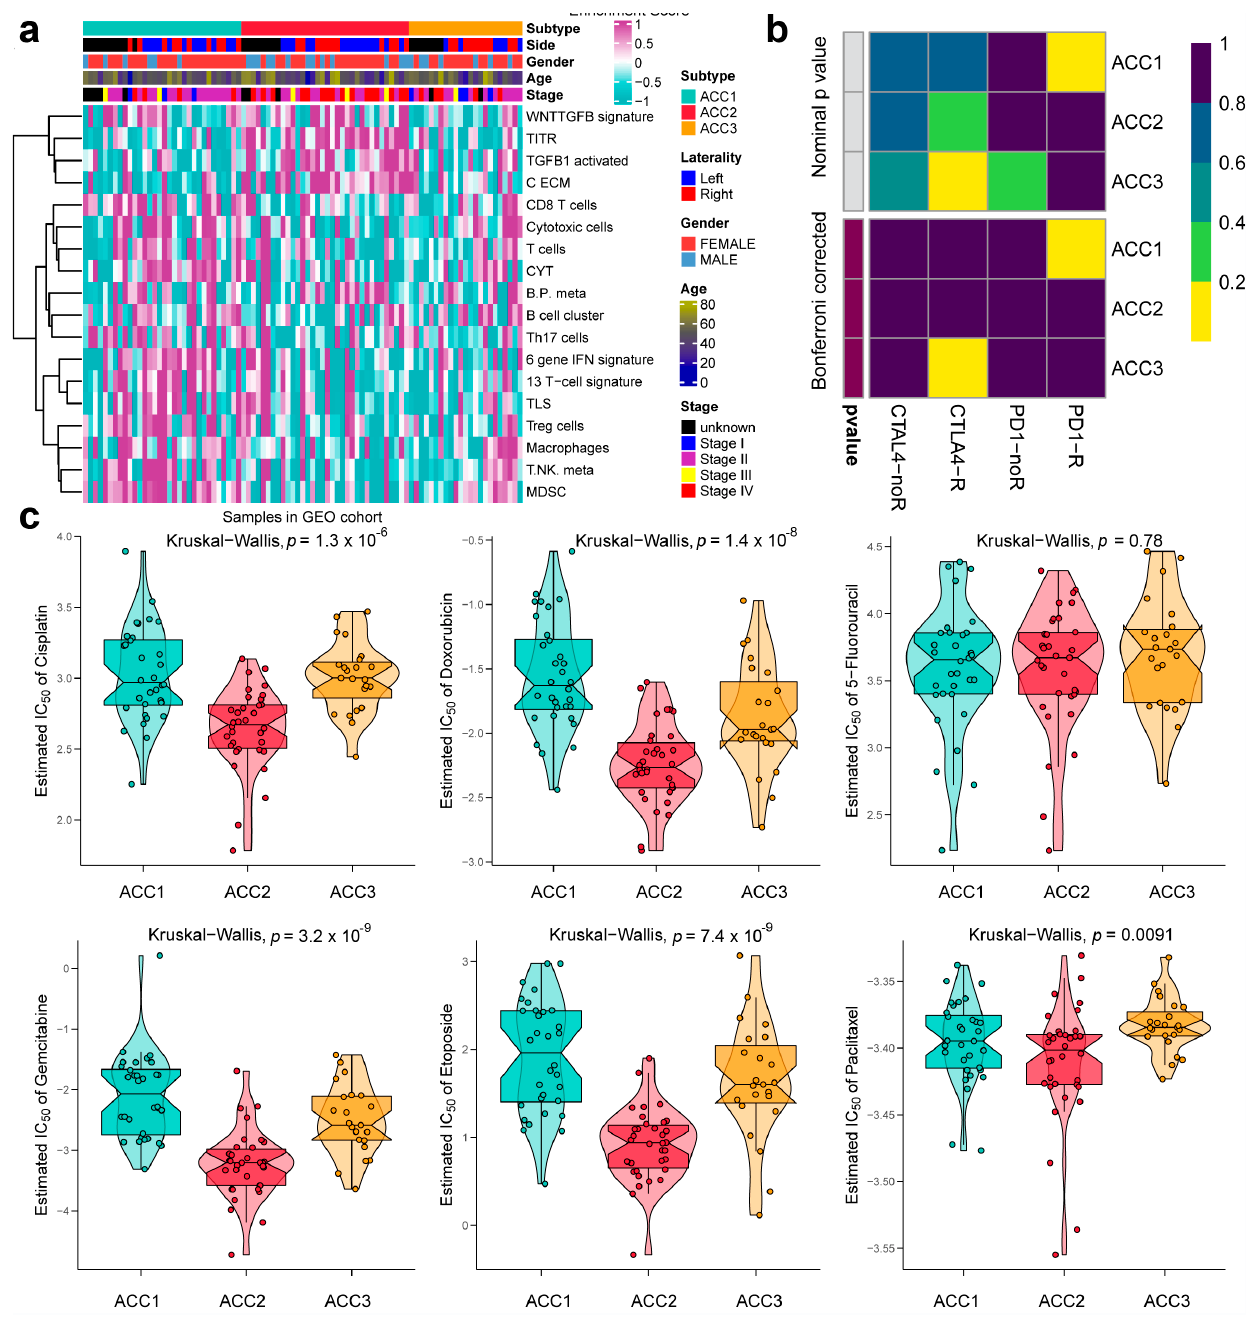
Figure 9. Differences in immune infiltration and chemotherapy susceptibility of three subtypes in GEO cohort. ( a ) Heatmap of infiltration landscape of different immune cells between the three subtypes. ( b ) SubMap analysis of anti-PD-L1 therapy. ( c ) Differences in chemotherapy susceptibility between the three subtypes. Table 1. Prognostic value of ACC subtype after adjusting for clinicopathological parameters.